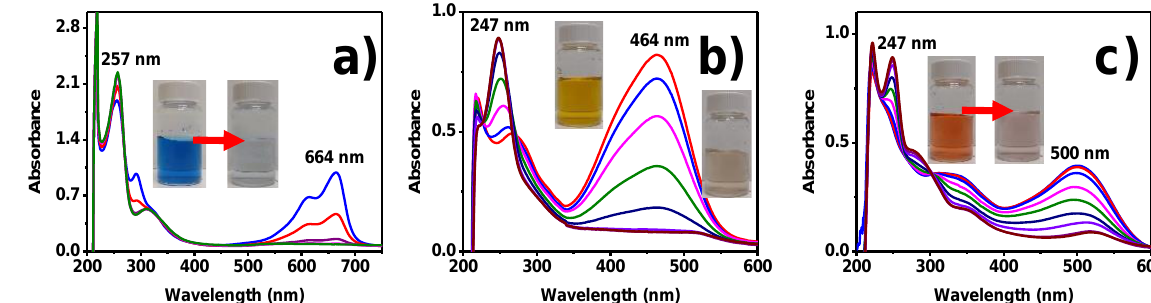
Figure 10. UV-Vis analysis of the degradation of ( a ) methylene blue, ( b ) methyl orange, and ( c ) methyl red using AuNPs.